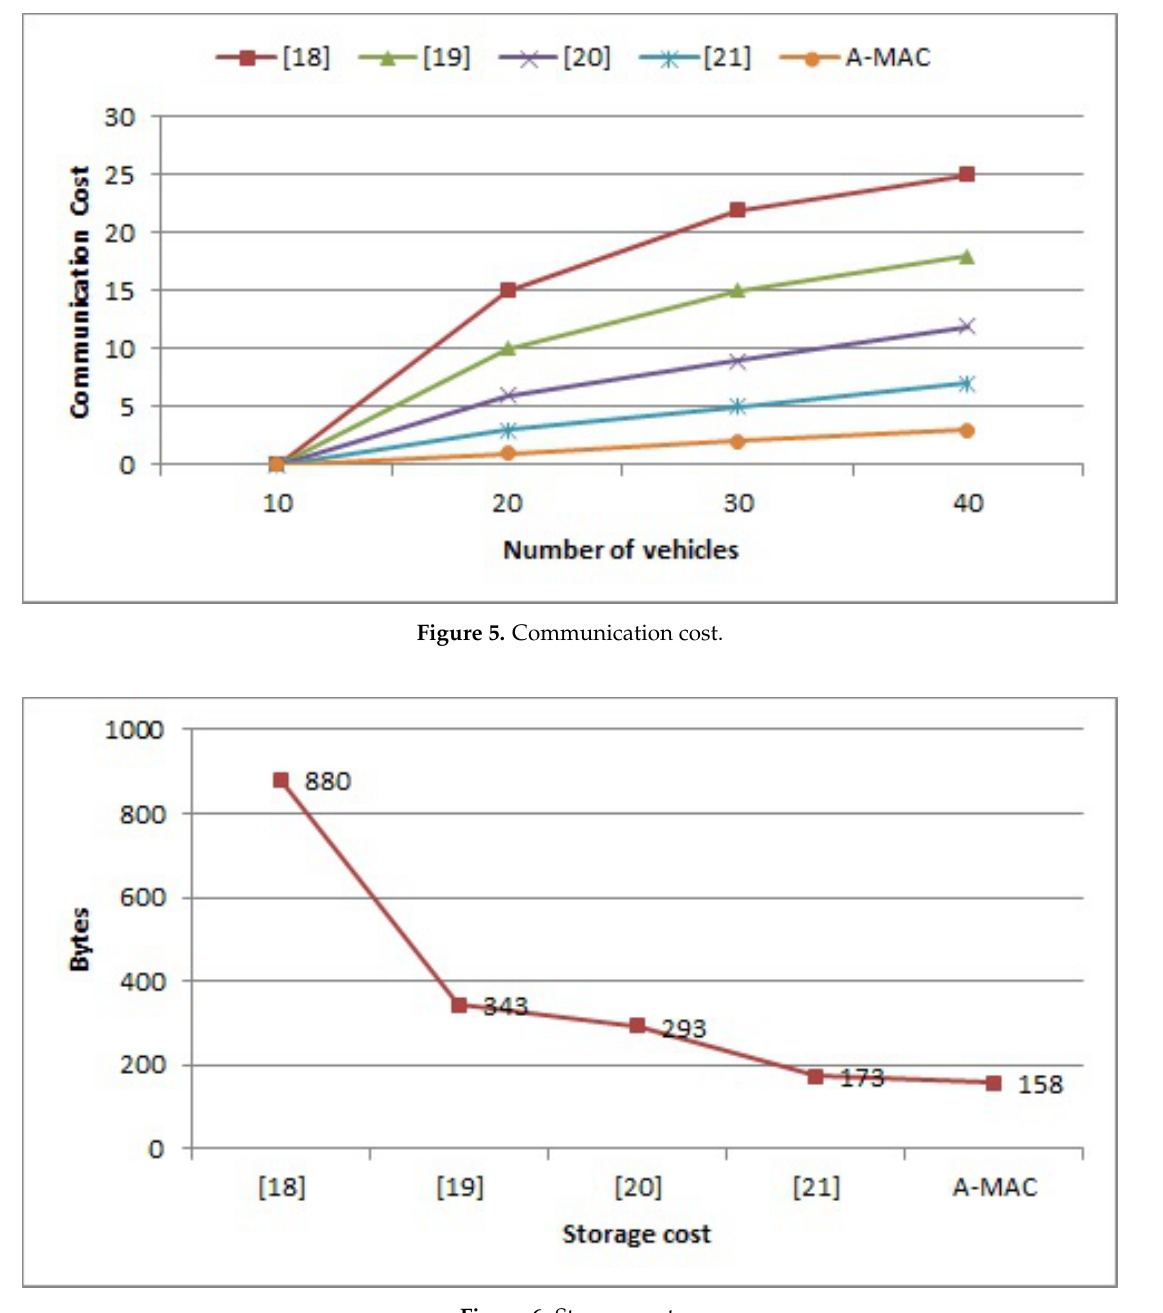
Figure 6. Storage